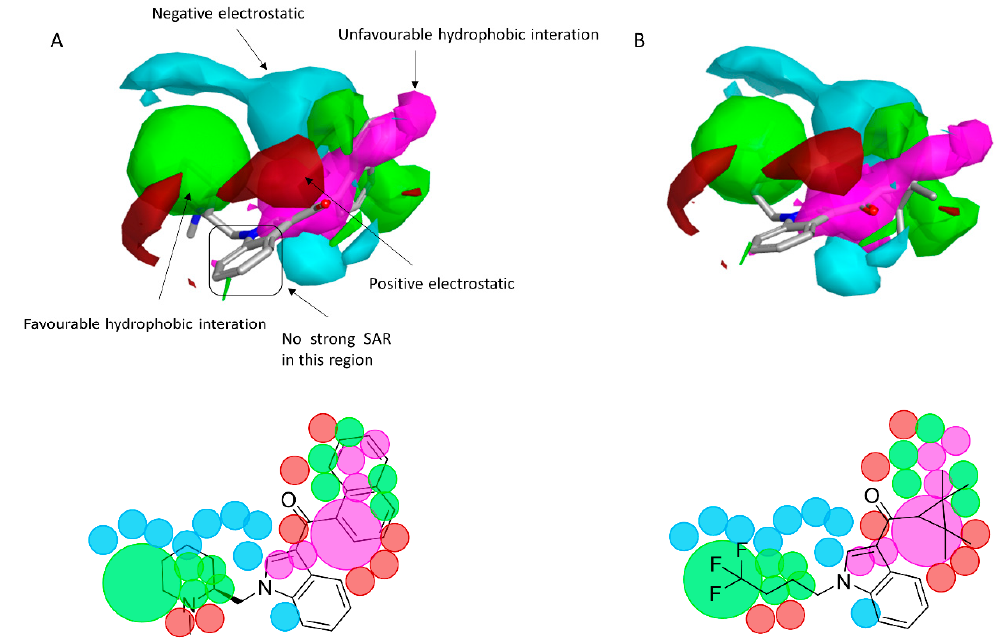
Figure 8. ( A ) The CB 1 model map superimposed to AM-1220. ( B ) The CB 1 model map is superimposed to XLR-12. Molecular insight of SAR mechanism models, revealing the different lead optimization sites of active compounds. Red color shows positive field region controlling the activity, and blue color the negative ones. Green color shows favorable shape/hydrophobic regions, and purple color the unfavorable ones.